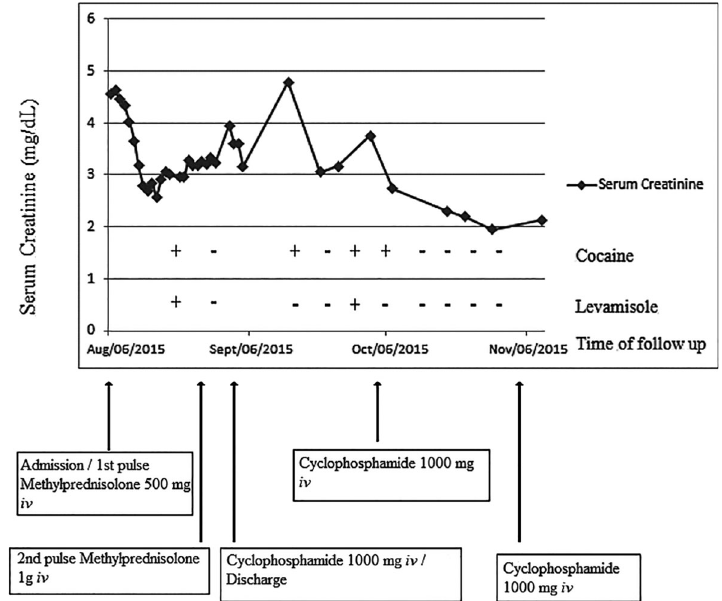
Figure 3. Evolution of renal function over 3 months of follow-up and its relation to urine toxicology for cocaine and levamisole, and to therapeutic interventions (methylprednisolone and cyclophosphamide intravenous ( iv ) pulses).